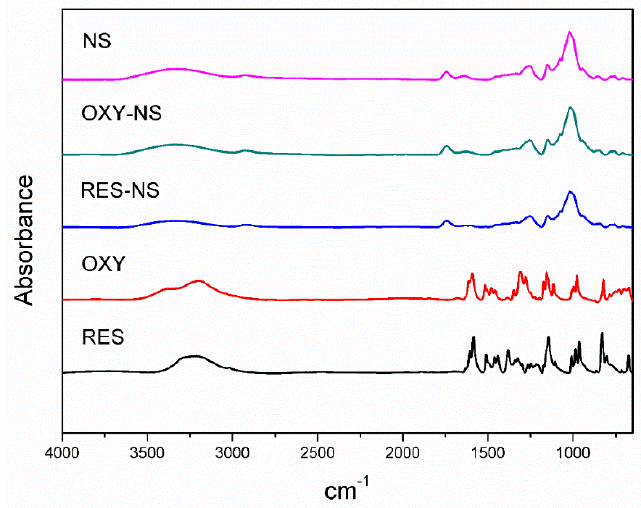
Figure 4. FTIR spectra of RES, OXY, RES-NS, OXY-NS, and blank NS.